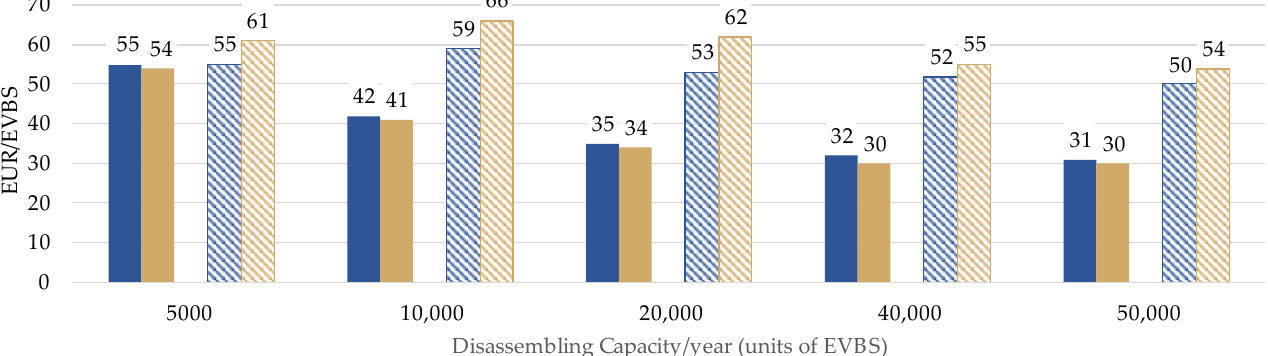
Figure 9. Variable and fixed costs per EVBS for different disassembling plant sizes in Germany.